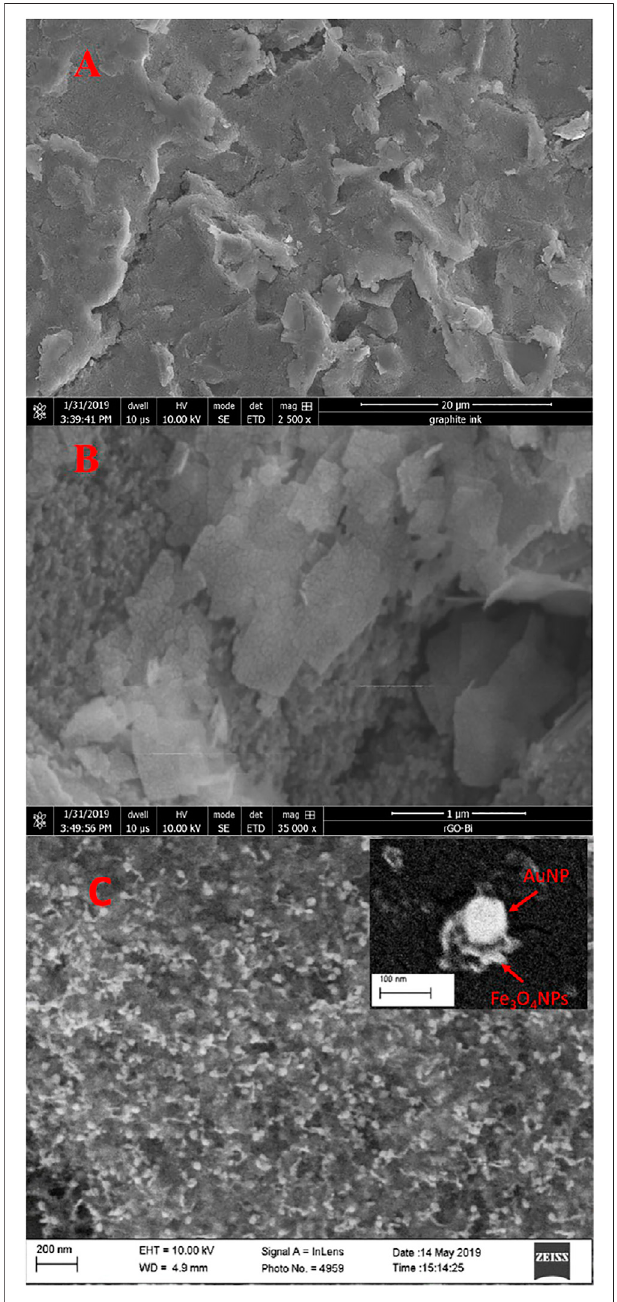
FIGURE 4 | SEM images of (A) bare SPE, (B) (BiO) 2 CO 3 -rGO-Na fi on/ SPE and (C) Fe 3 O 4